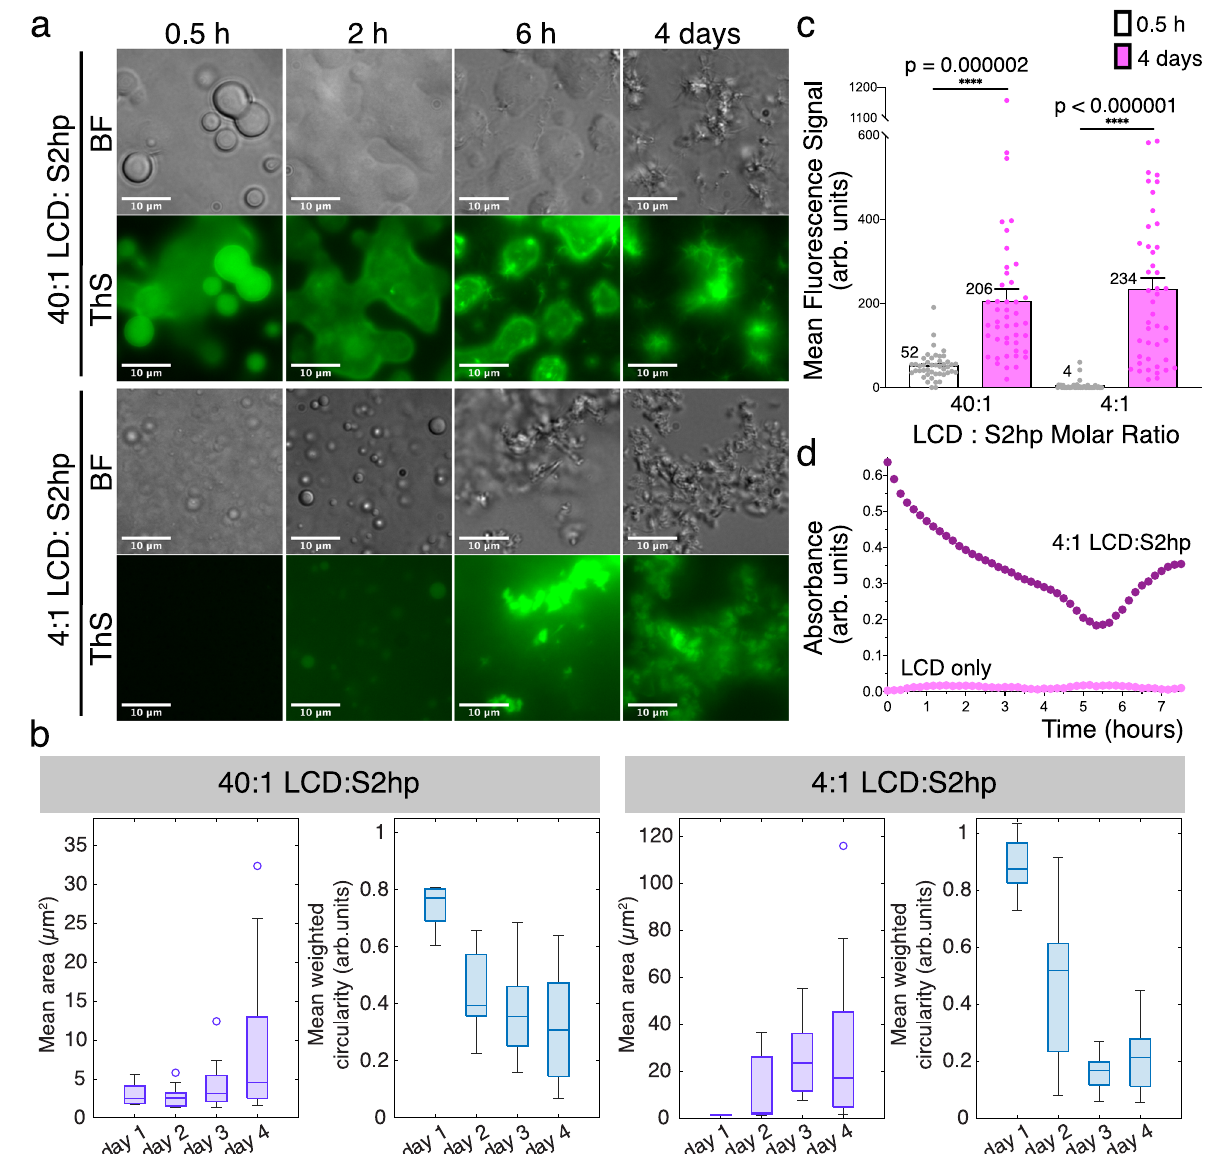
correction. The p values are indicated with numbers and stars — **** p